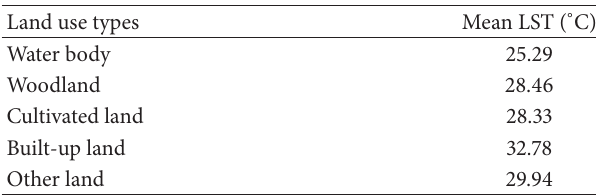
Table 1: Land use types and their corresponding mean LST in Wuhan city.